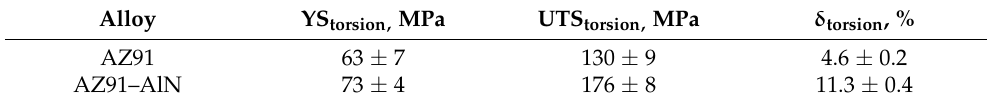
Table 3. Mechanical properties of AZ91 magnesium alloys after torsion